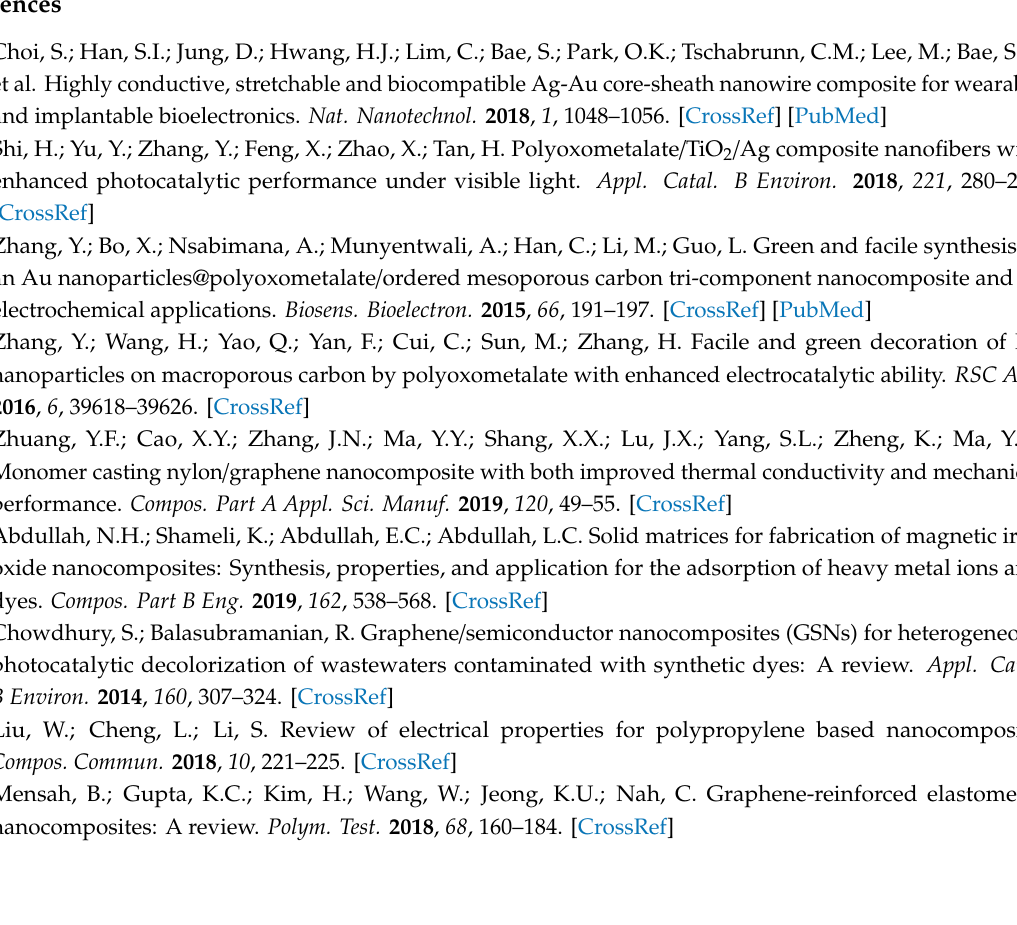
Figure S1: SEM-EDS analyses of Fe 3 O 4 / Ag nanoparticles. Figure S2: Thermogravimetric analyses of (a) Fe 3 O 4 / Ag nanoparticles and (b) Fe 3 O 4 / Ag / POMs nanocomposites. Figure S3: (a) STEM image and (b–i) corresponding elemental mappings of Fe 3 O 4 / Ag / POMs